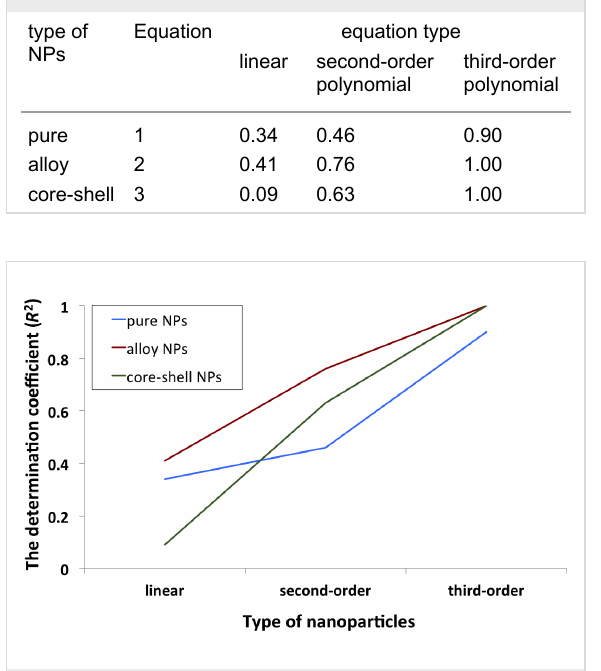
Table 4: Correlations value for each type of equation.